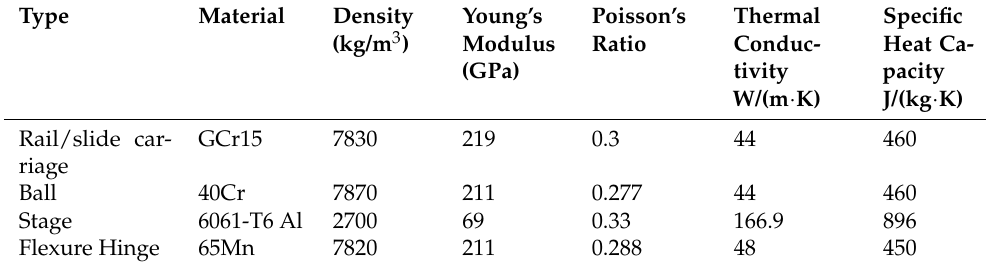
Table 2. Main parameters of